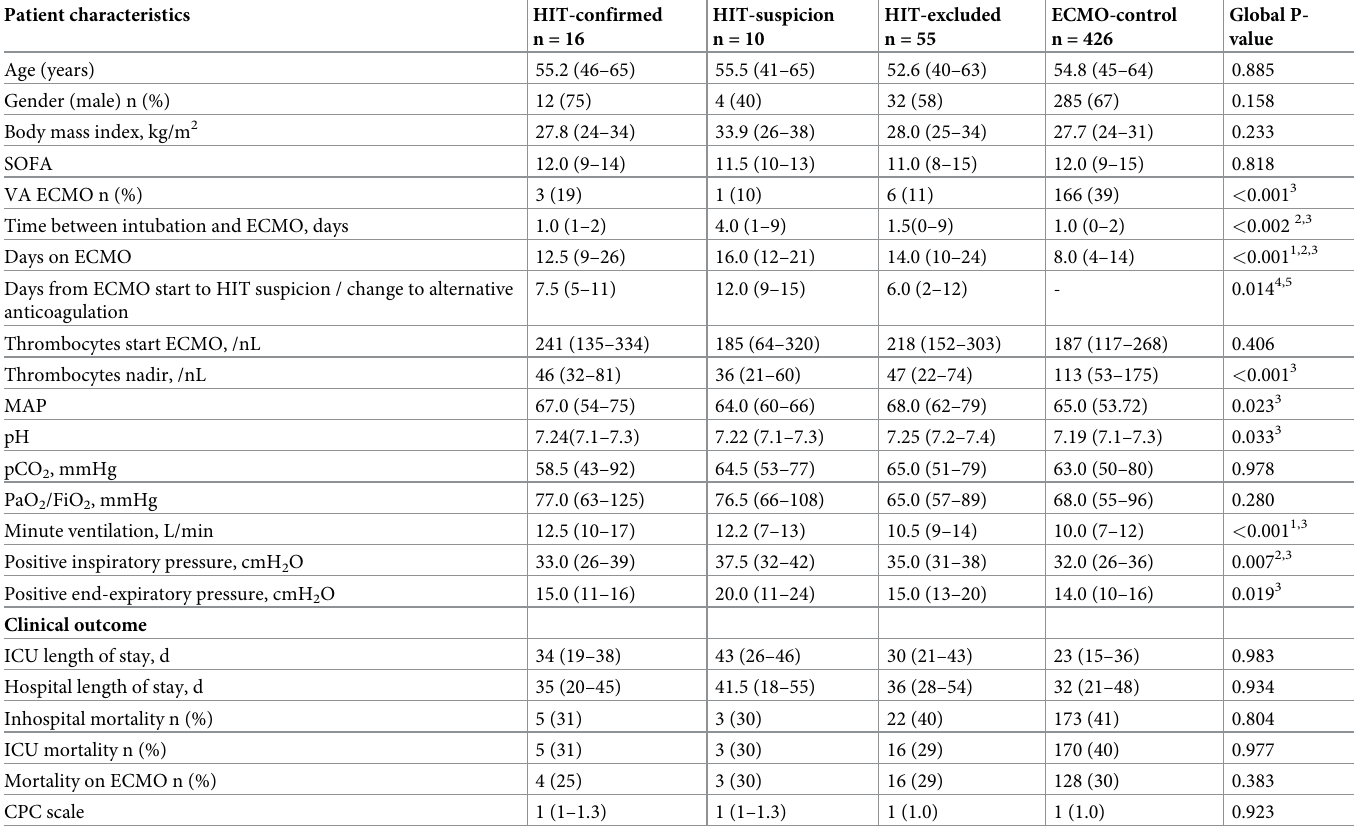
Table 1. Patient Characteristics at initiation of extracorporeal membrane oxygenation and